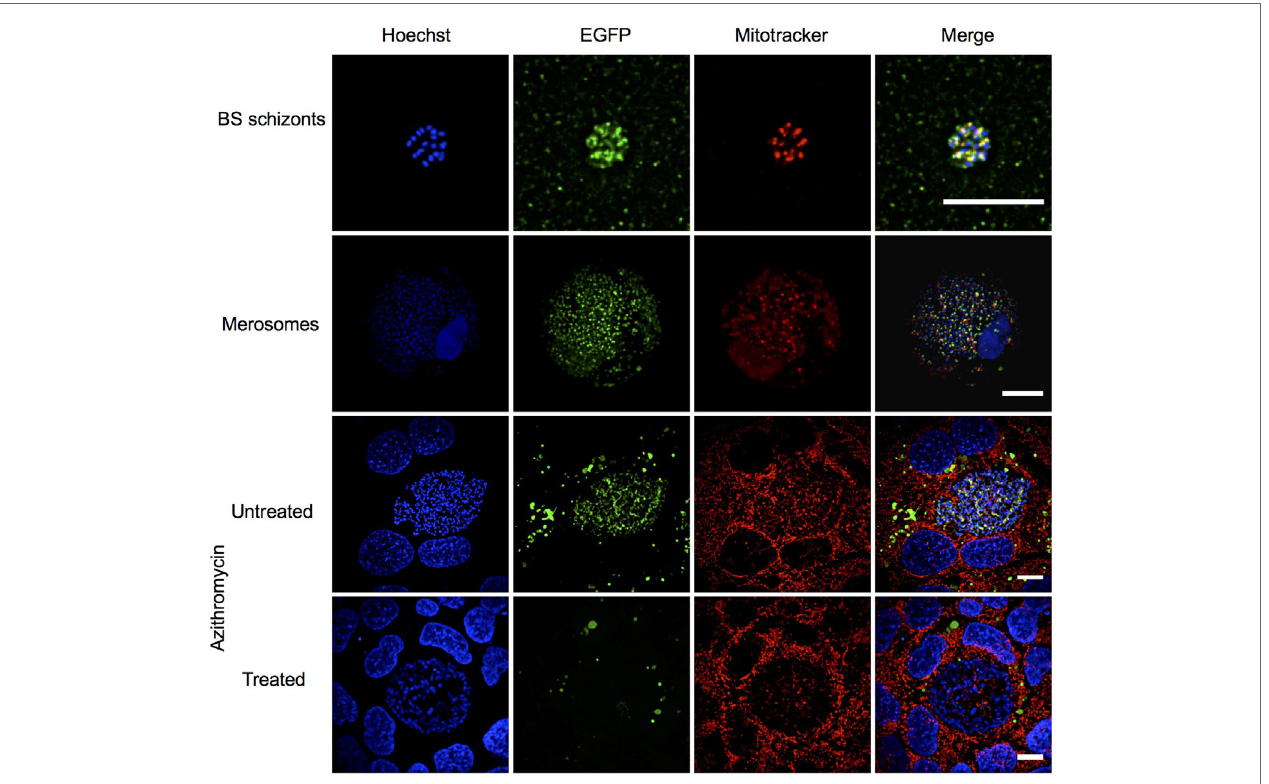
FigUre 2 | Pb maLS_05 localizes to the apicoplast of liver and blood-stage parasites. Pb maLS_05 EGFP parasites were co-stained with Mitotracker and imaged live using a spinning disk confocal microscope. Pb maLS_05 EGFP liver stages treated with 1 µM azithromycin did not show the branched structure for Pb maLS_05, as previously observed in untreated liver stage schizonts, thus confirming targeting of Pb maLS_05 to the apicoplast. The images displayed are representative of two independent experiments. Scale bar = 10 µm; for merosomes scale bar = 80